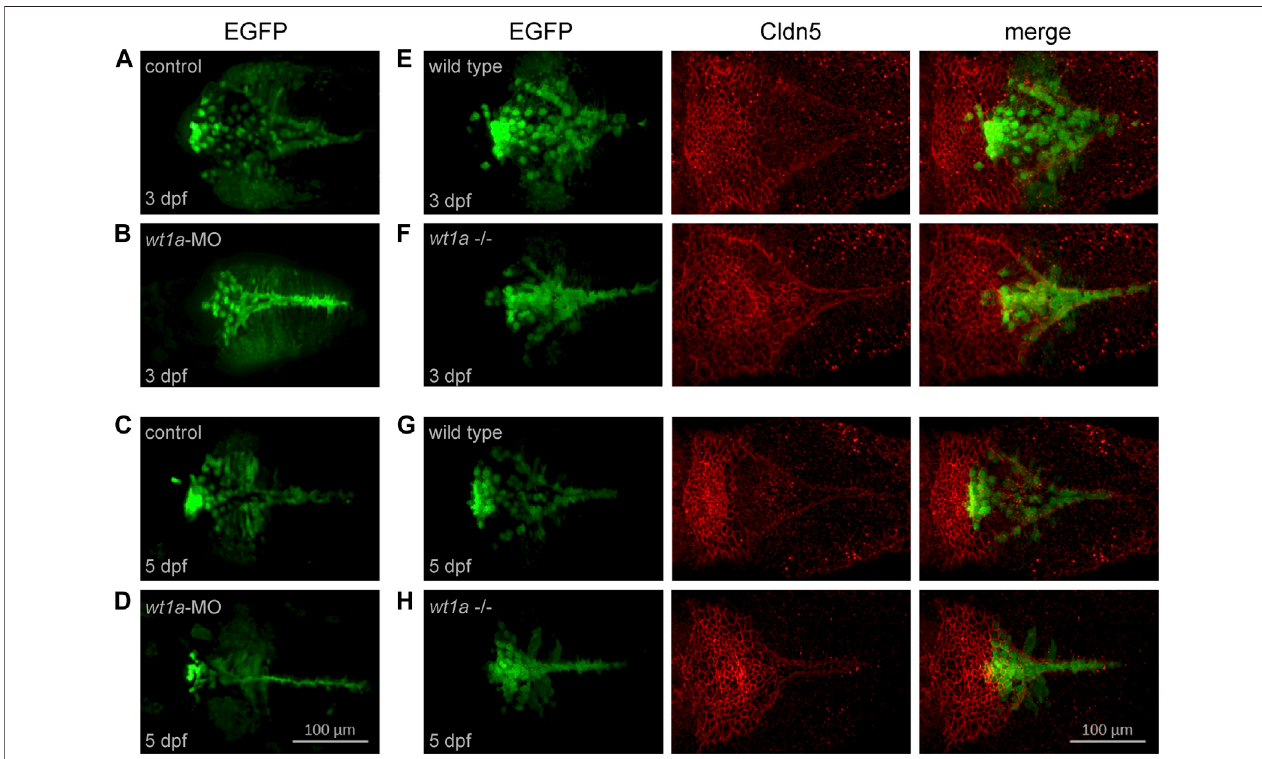
FIGURE 4 | Wt1a morphants and mutants show anomalies in choroid plexus development. For the analysis of morphants the Tg(wt1a:EGFP) line and for mutants the Tg(wt1a:EGFP);wt1a ex1_del5 linehasbeenused. (A – D) Wt1+positivecells,visualizedbyEGFP fl uorescence,inzebra fi shlarvaeinjectedwithcontrolmorpholino(A,C) or wt1a morpholino (B,D) at three dpf (A,C) and fi ve dpf (B,D). (E – H) Wt1+ positive cells ( left ) , visualized by EGFP fl uorescence in wildtype (E,G) or homozygous wt1a mutant larvae (F,H) of the Tg(wt1a:EGFP) line were stained with a -Cldn5 antibody ( middle ) at three dpf (E,F) and fi ve dpf (G,H). All panels represent 3D reconstructions of image stacks (dorsal views with rostral to the left ).